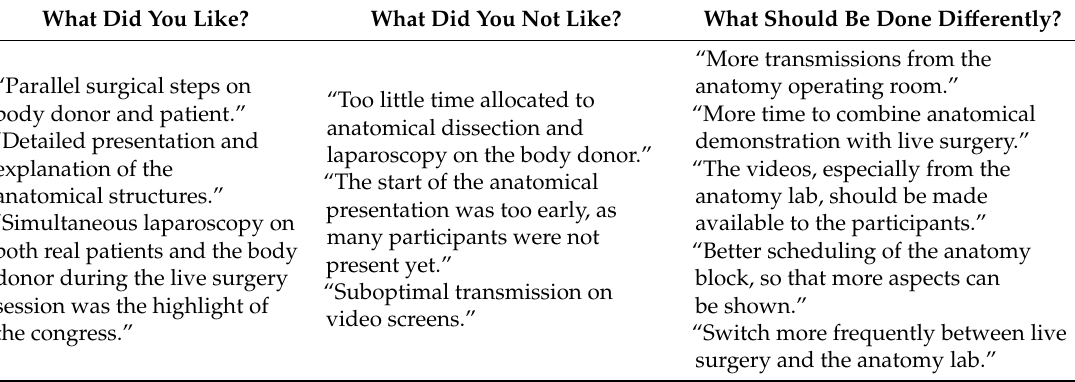
Table 3. Praise and criticism of live surgery performed on body donors.